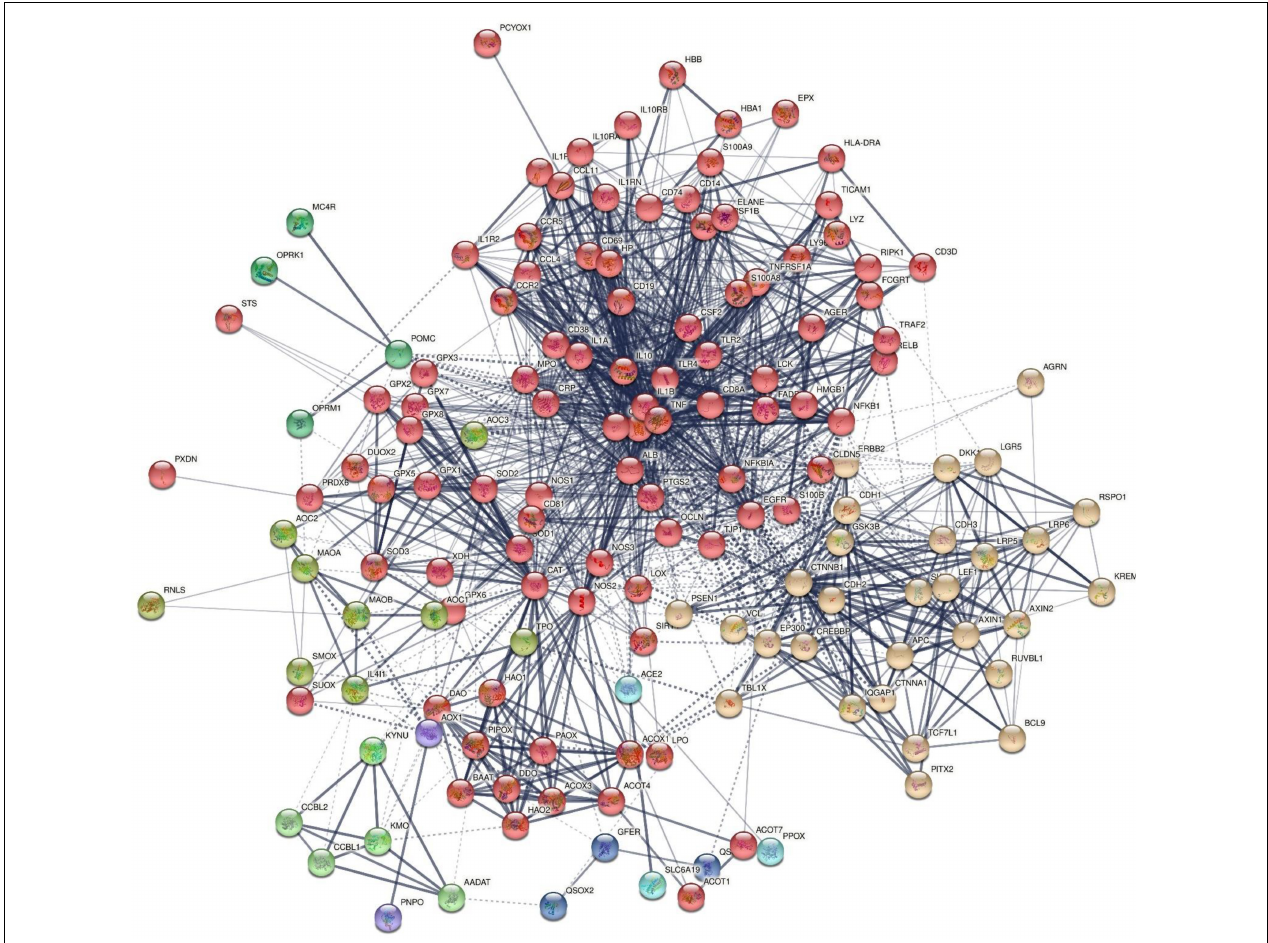
FIGURE 2 | First-order protein network of chronic fatigue spectrum disorders. MCL cluster analysis found two major subnetworks: (1) a first immune, oxidative, and nitrosative subnetwork (IO&NS) (red color) was centered around NOS2, NFKB1, IL-10, etc, and (2) a second Wnt/ β -catenin subnetwork (yellow nodes) was centered around CTNNB1. The tryptophan catabolite pathway [kynurenine hydroxylase (KYNU) and kynurenine 3-monooxygenase (KMO)] and opioid [opioid receptor Kappa 1 (OPRK1) and opioid receptor Mu 1 (OPRM1)] genes appear to be spin-offs of the IO&NS subnetworks. The solid and dotted lines represent connections inside and between clusters, respectively. Different colors represent the various